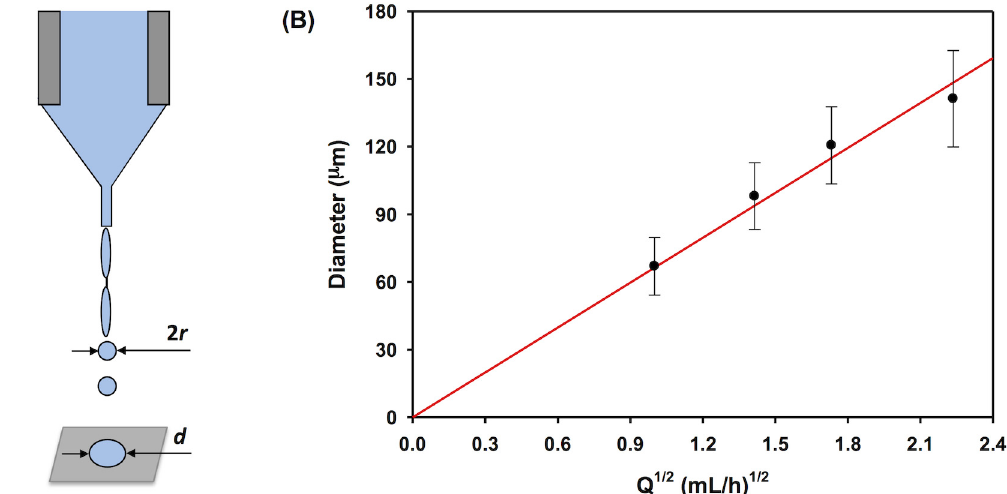
Fig 3. Formation of primary electrosprayed droplets. (A) Schematic diagram of the droplets formed from a jet through Rayleigh ’ s capillary breakup under a cone-jet mode during electrospraying process. (B) The diameter of deposited droplets vs. the square root of flow rate using the improved electrospraying setup with circular shielding electrode as shown in Fig